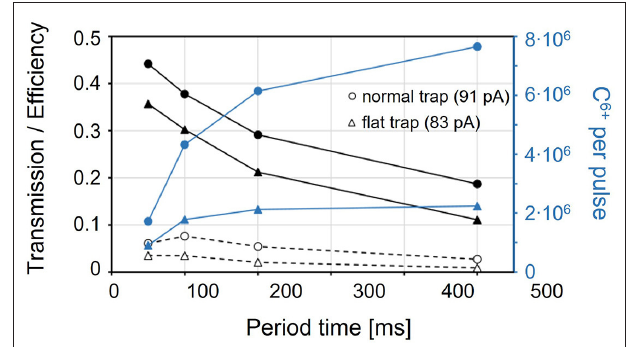
FIGURE 8 | Transmission through REXTRAP (black solid line, including exiting C + , O + , H 2 O + and CO + beams) and total efficiency of carbon ions (charge bred to C 6 + ) through REXTRAP and REXEBIS (dashed) for a normal (circle) and a flat (triangle) axial trapping potential in the Penning trap, with an input beam of 91pA and 83pA, respectively. The blue curves correspond to the total number of C 6 + ions extracted from the charge breeder system